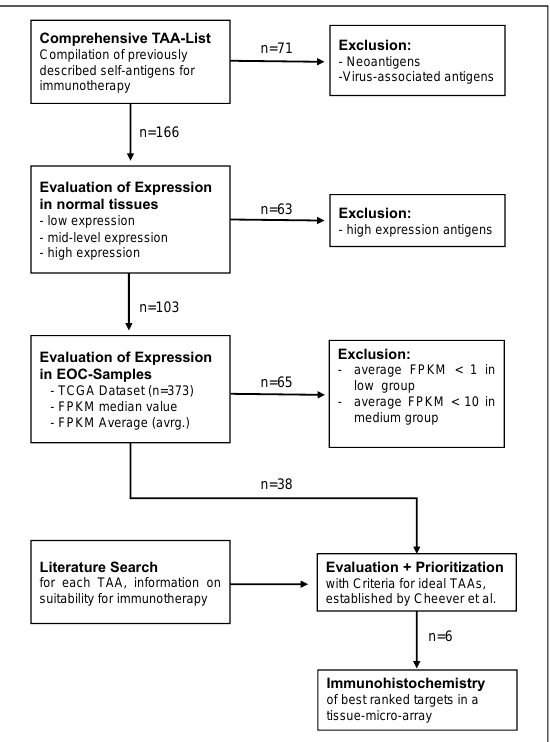
Figure 1. Flow Chart illustrating the process of TAA selection: after exclusion of TAAs with high expression in healthy tissue or low expression in EOC, 38 self-antigens were included in evaluation and prioritization, 6 targets were chosen for